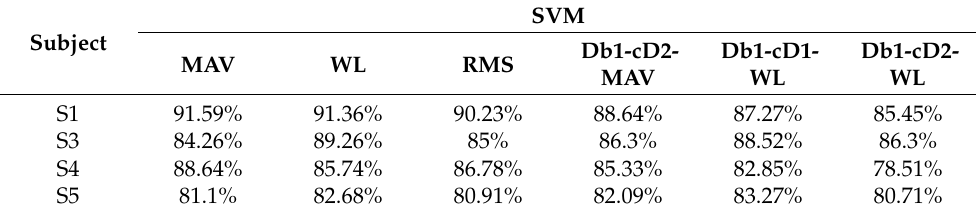
Table 3. Overall classification accuracy of individual sEMG features, SVM classifier.